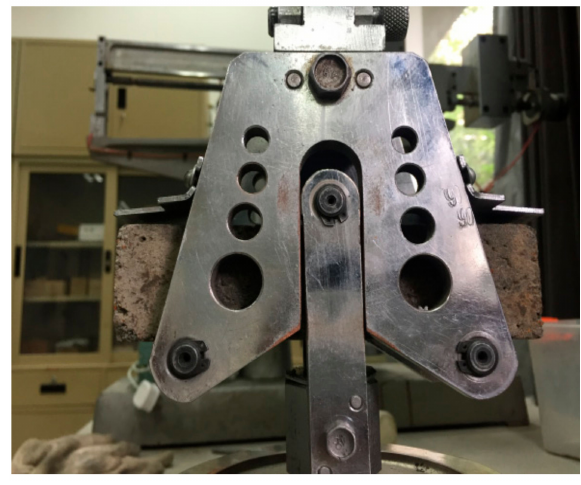
Figure 7. Flexural loading test of